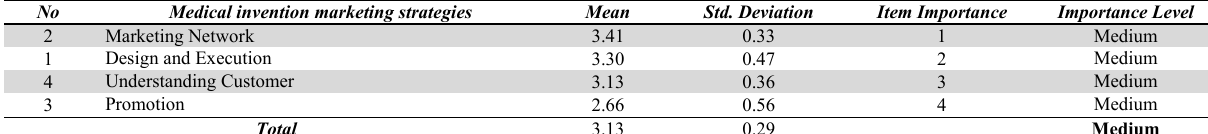
Arithmetic Mean, SD, Item Importance and Importance level of medical invention marketing strategies No Medical invention marketing strategies